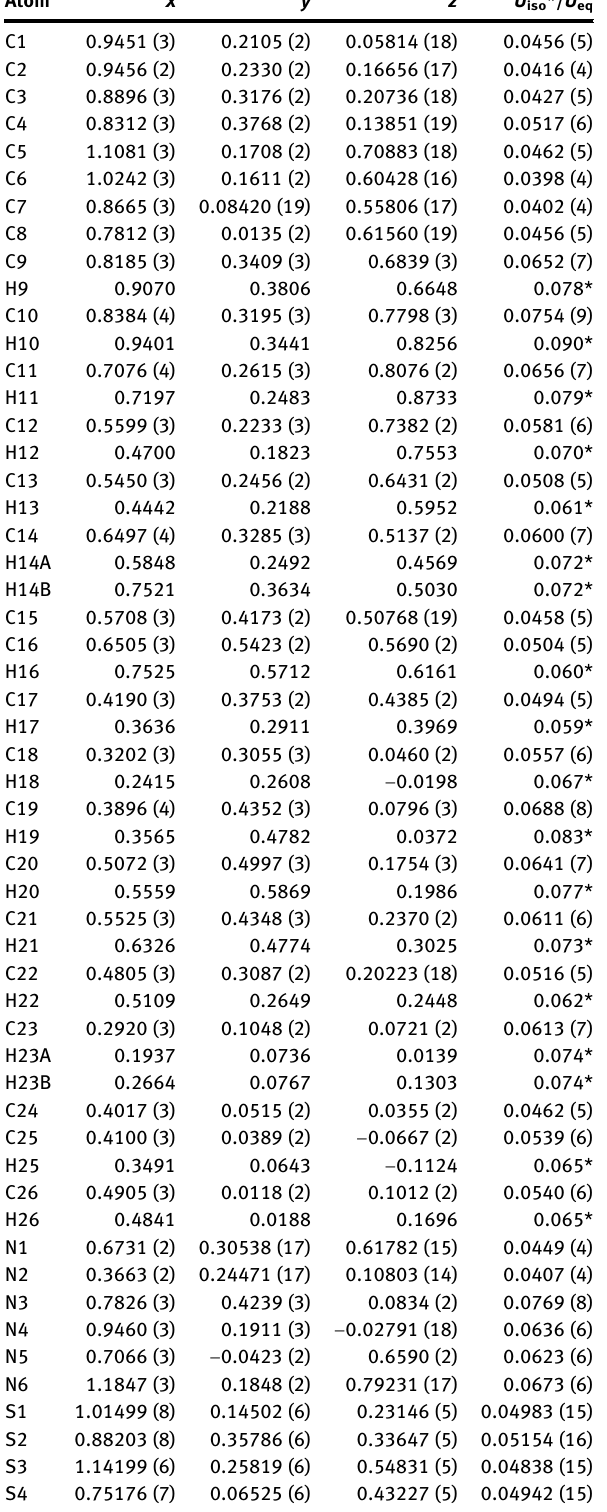
Table  : Fractional atomic coordinates and isotropic or equivalent isotropic displacement parameters (Å 